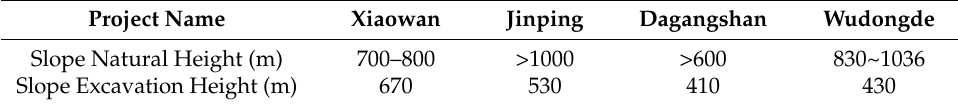
Figure 1. A bird’s eye view of Jinping I Hydropower Station by man-made satellite. Table 1. Height of the dam abutment slopes for some hydro-power stations in southwest China 1